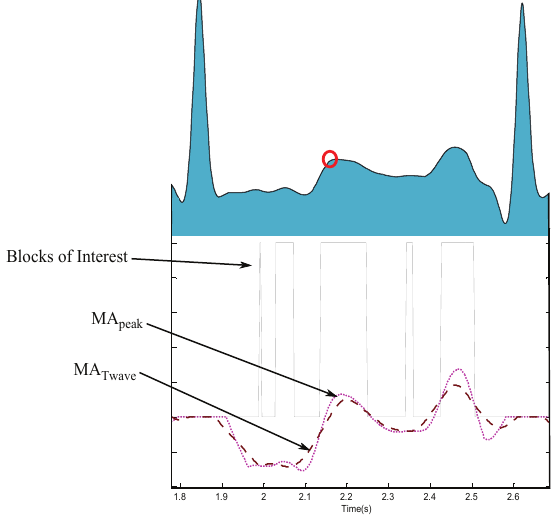
Figure 7. Demonstrating the effectiveness of using two moving averages to detect T waves. The dotted line is the first moving average, while the dashed line is the second moving average. The red circle is the detected T wave